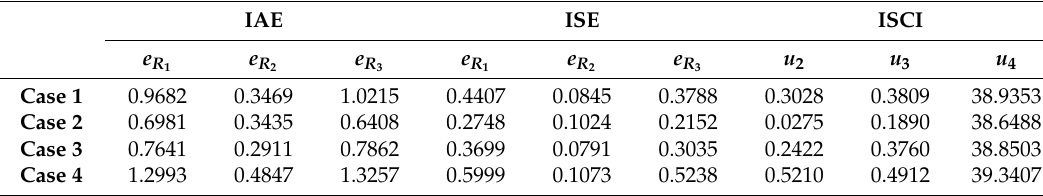
Table 3. Comparison of performance of SMC with different sets of